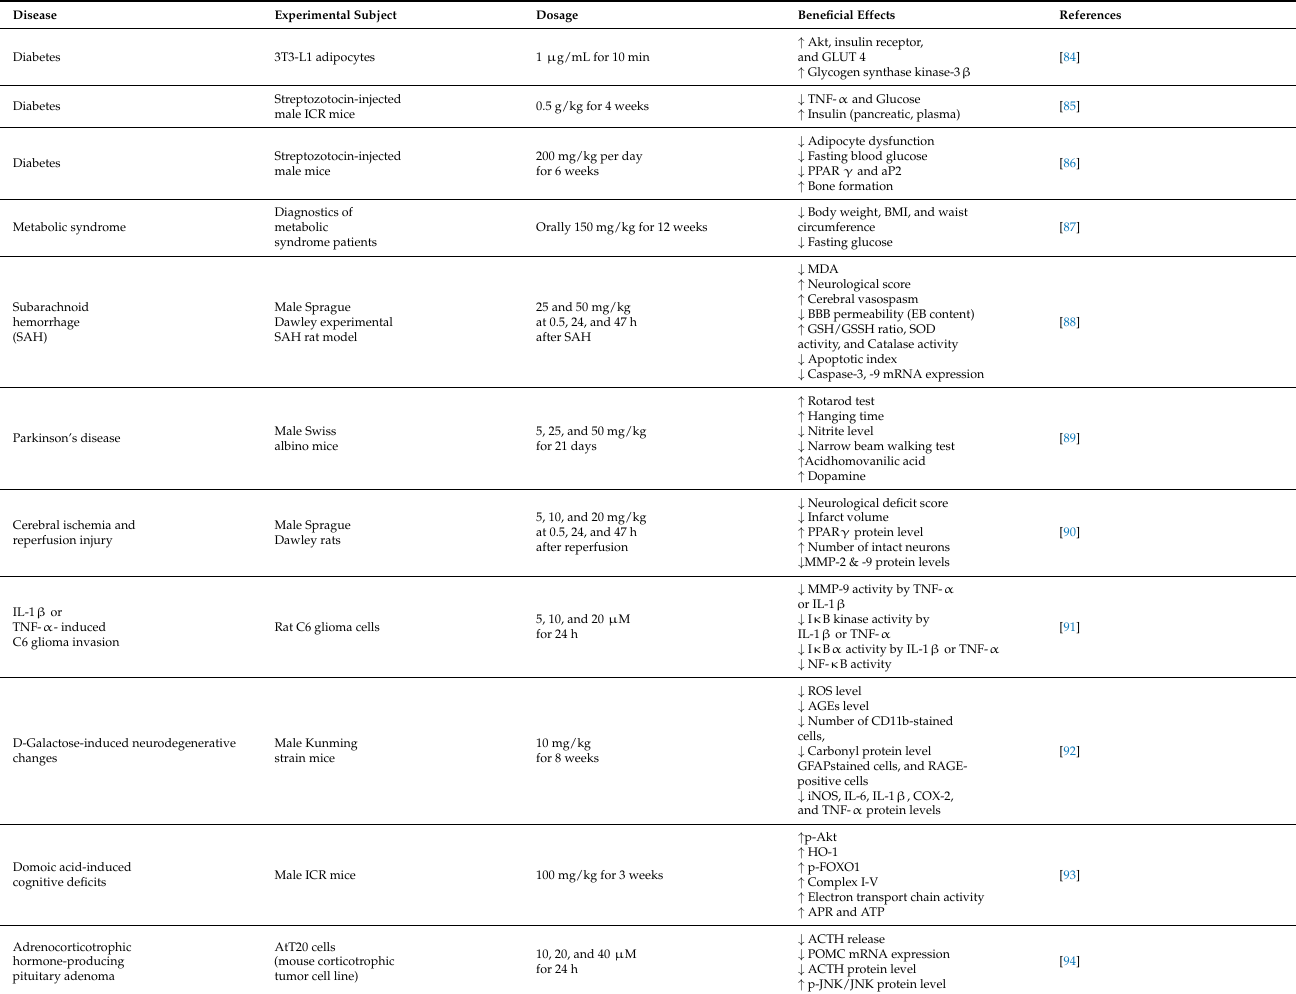
Table 2. UA effects on diabetes and brain